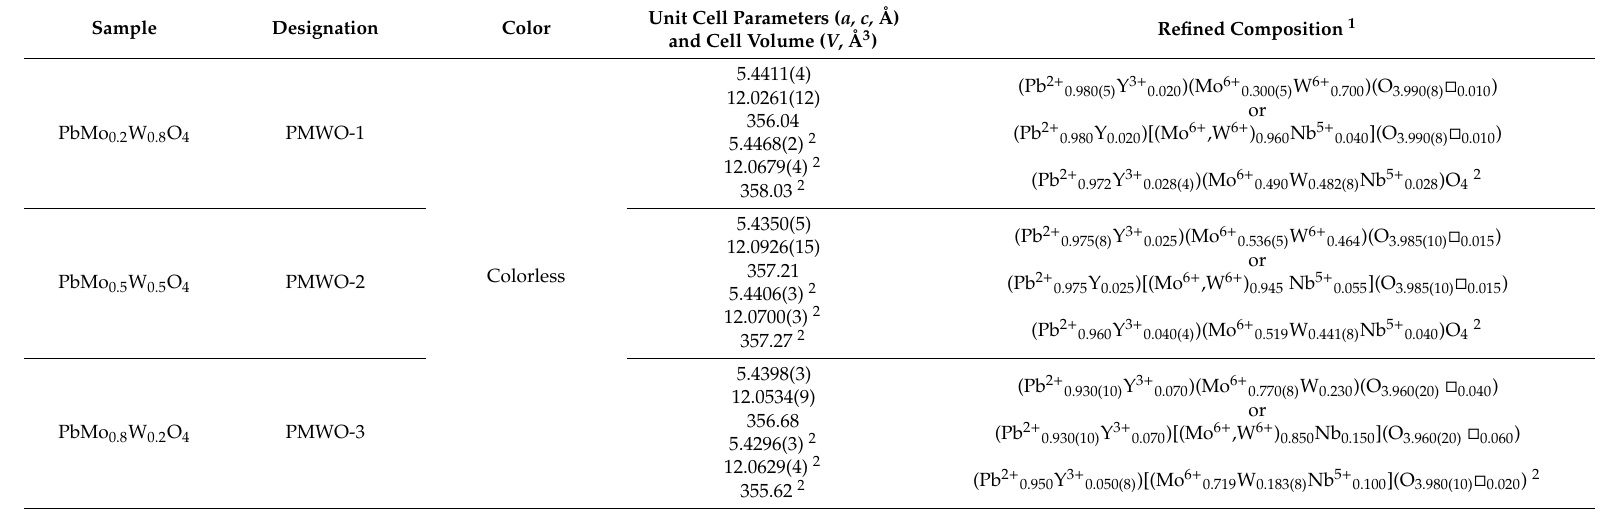
Table 2. Refined compositions of PbMo x W 1 − x O 4 (PMWO) crystals according to single-crystal X-ray (XRD) and neutron di ff raction (ND) analysis.